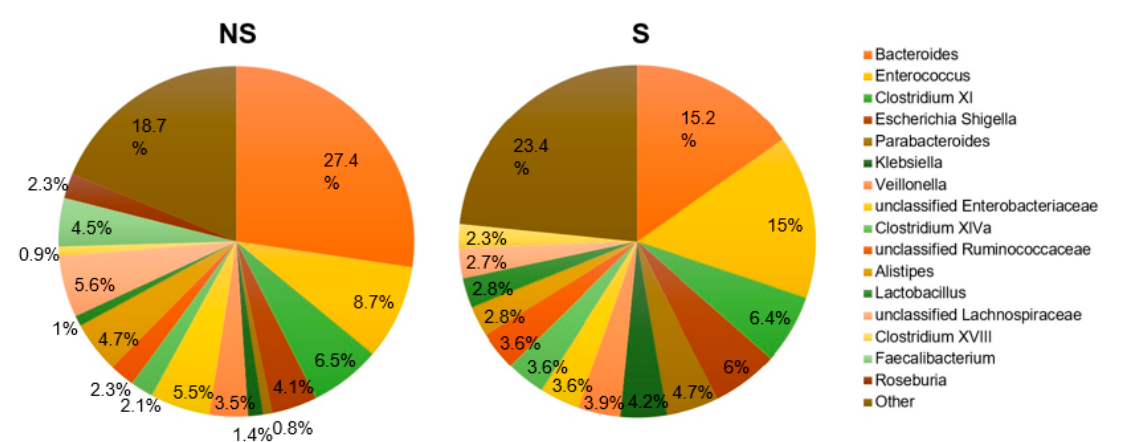
Figure 5. Comparison of taxonomic composition of microbiota in severe and non-severe C. difficile infection. Compared average relative abundances of phyla, families and genera identified in the two study groups. NS = non severe disease; S = severe disease.